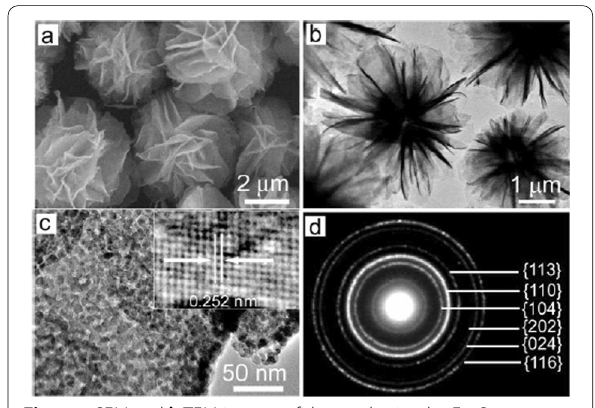
Fig. 4 a SEM and b TEM images of the as-obtained α-Fe 2 O 3 . c High-magnification TEM image of the petal of the flowerlike structure of the as-obtained α-Fe 2 O 3 . d SAED pattern of the obtained α-Fe 2 O 3 . Reprinted with Permission from [65]. Copyright, Wiley-VCH